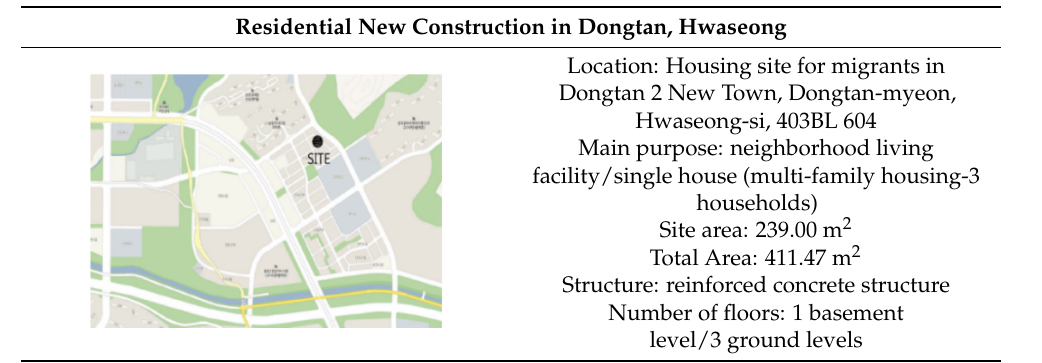
Table 7. Overview of the first project to be tested.